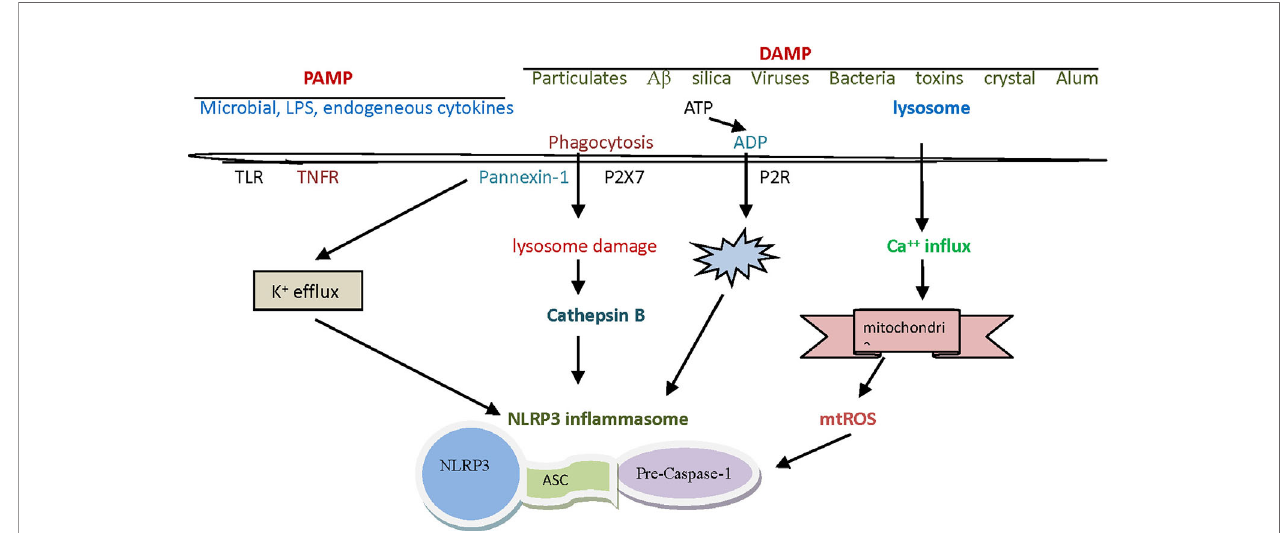
FIGURE 1 | The assembly and activation of The NLRP3 in fl ammasome. The NLRP3 in fl ammasome is a complex composed of NLRP3, ASC and caspase-1 precursor proteins, in which NLRP3 protein plays a leading role. ASC is a cohesive protein of this speci fi c in fl ammasome, whose amino terminal contains pyrin domain and carboxyl terminal contains CARD domain. The initiation signals of activating NLRP3 in fl ammasome are some internal and external activators, including a variety of PAMP and DAMP. NLRP3, nucleotide-binding domain leucine-rich repeat and pyrin domain containing receptor protein 3; ASC, apoptosis associated speck like protein containing cysteine aspartic proteinase recruitment domain; CARD, cysteine aspartic proteinase recruitment domain; PAMP, pathogen-associated molecular patterns; DAMP, danger associated molecule